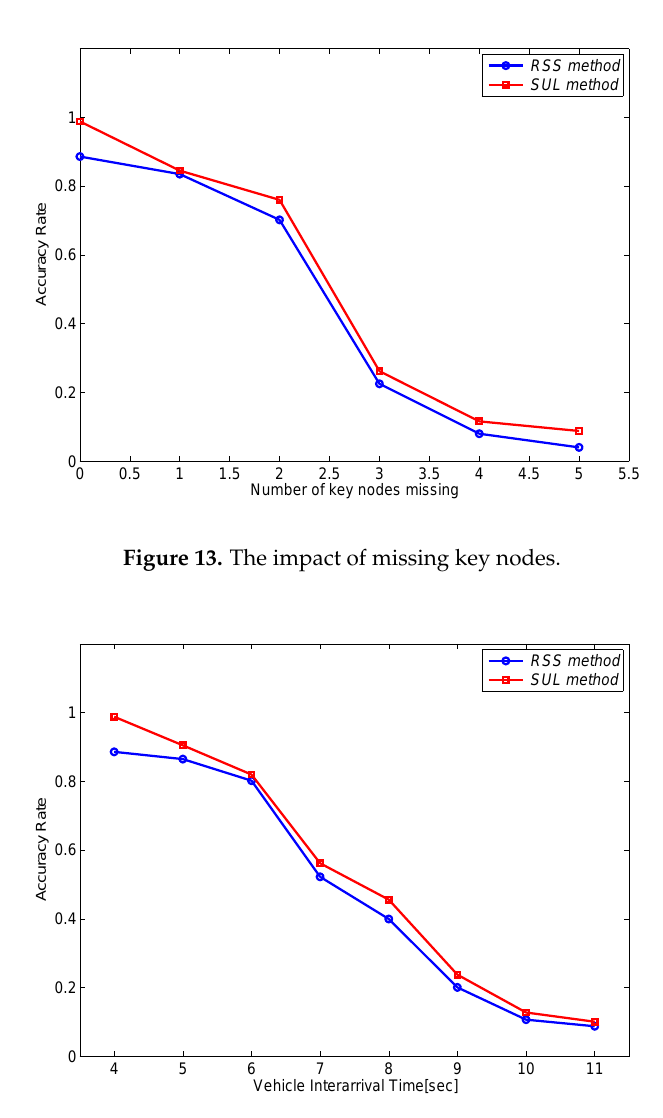
Figure 14. The impact of heavy